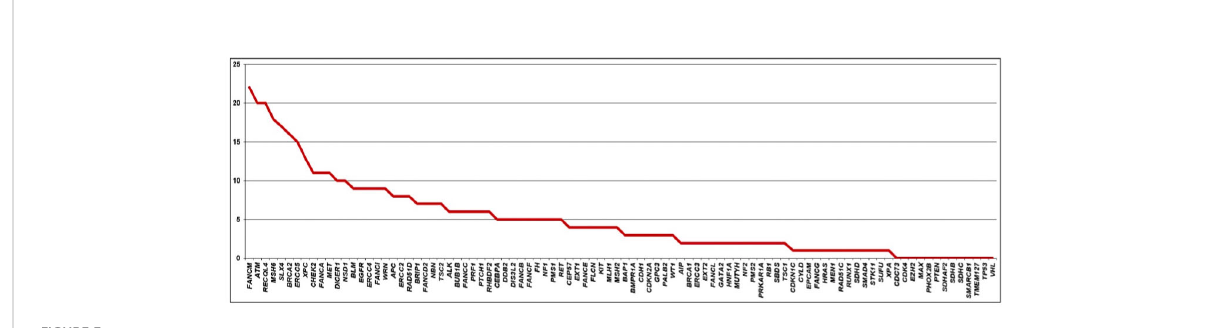
FIGURE 3 Distribution of variants of uncertain signi fi cance, according to the identi fi ed